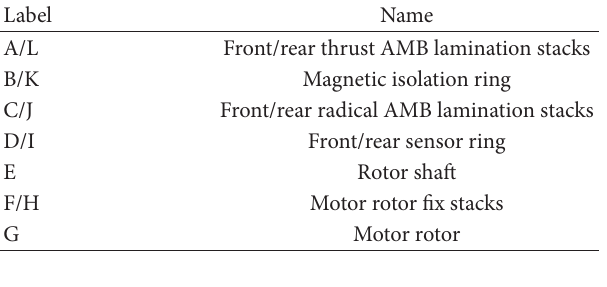
Table 2: Experimental and theoretical (no updating) modal fre-